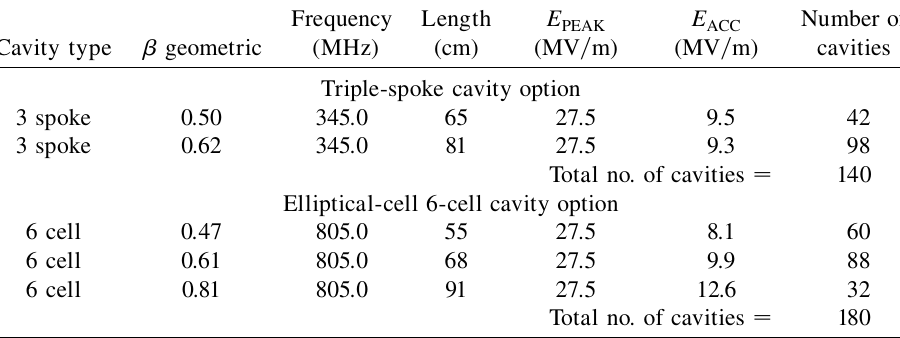
TABLE III. SC cavity arrays required for the high-energy section for the RIA driver linac for the two design options considered.